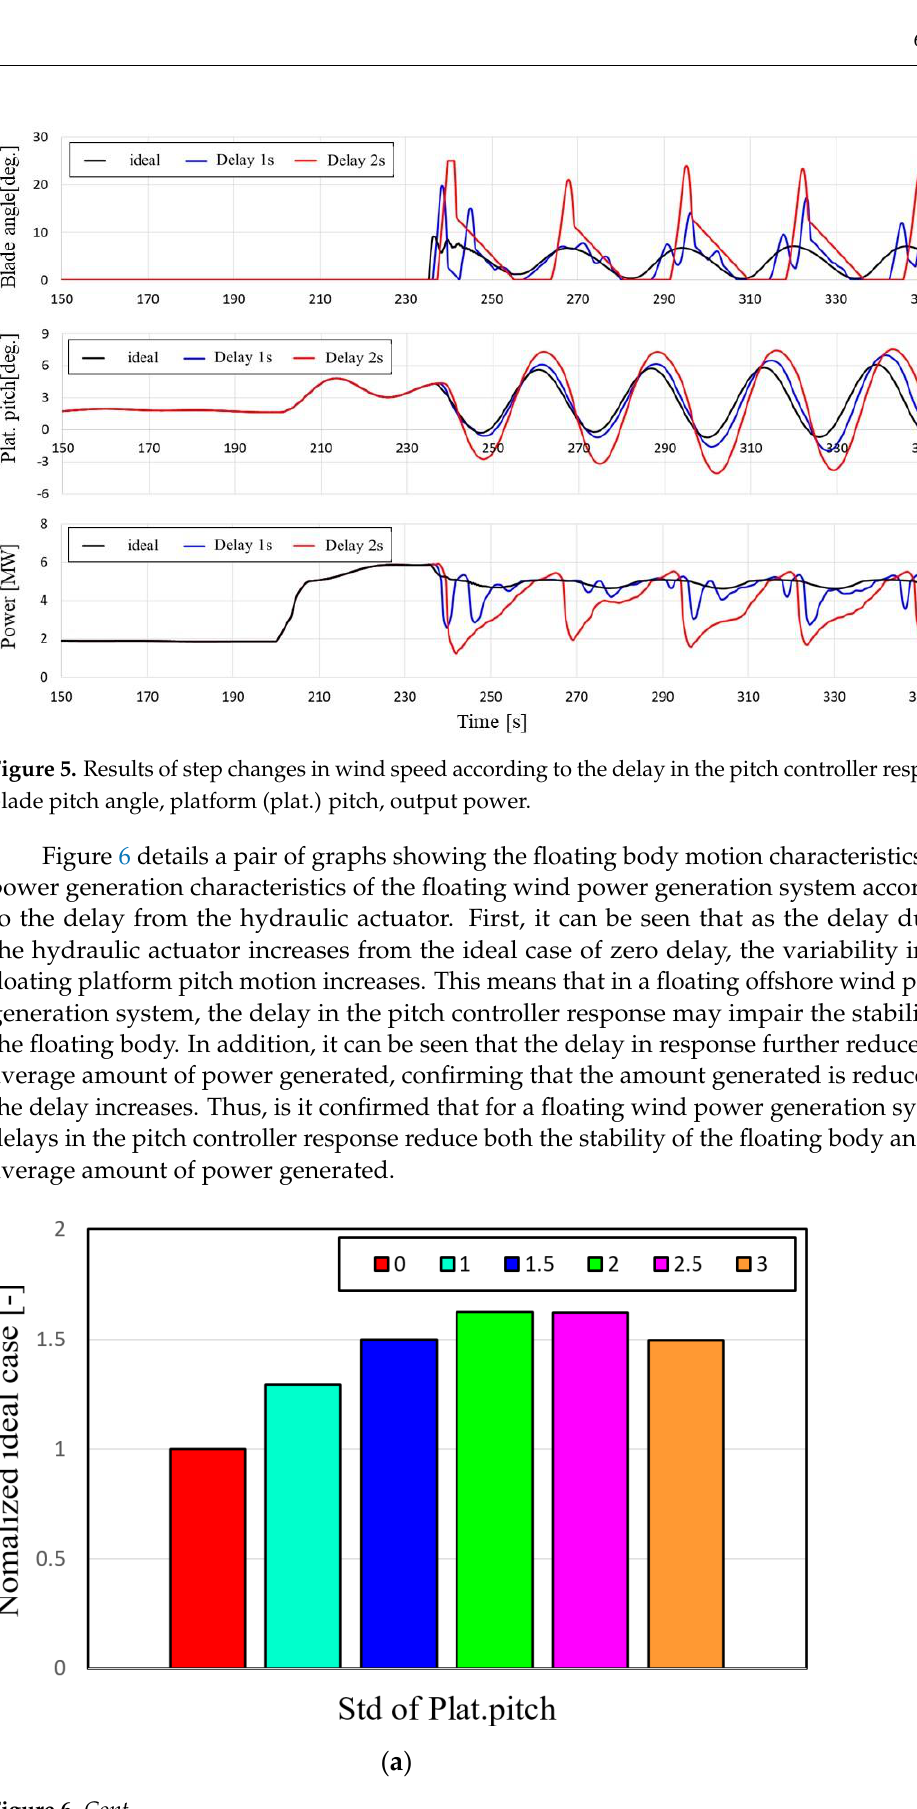
( b ) Figure 6. Characteristics according to delay time (s) of hydraulic actuator: ( a ) Standard deviation (std) of platform pitch motion of floating body; ( b ) average amount of power generated. 3. Materials and Methods 3.1. Pitch Control Angle Prediction System with Deep Learning Algorithm Data prediction studies have been conducted that use various deep learning algo- rithms in many applications. An algorithm for accurate prediction is constructed by con- sidering various input variables that affect the data to be predicted. Thus, if a control signal capable of compensating for the delay can be predicted by incorporating charac- teristics of the control signal that may occur as a result of the delay, it may be possible to recover the stability of the floating body and restore the amount of power generated. Therefore, in this study, the input data that affect the existing pitch controller are ana- lyzed, and the delay that may occur from the use of a hydraulic driving device is pre- dicted by applying a deep learning algorithm. Figure 7 shows the configuration of the proposed pitch controller with the deep learning algorithm applied. The deep learning algorithm predicts the leading blade pitch angle based on the delay occurring in the hydraulic actuator. If the blade pitch angle can be predicted as far in advance as the length of the delay occurring in the hydraulic actu- ator, the delay can be compensated. This will make it possible to reduce the pitch motion